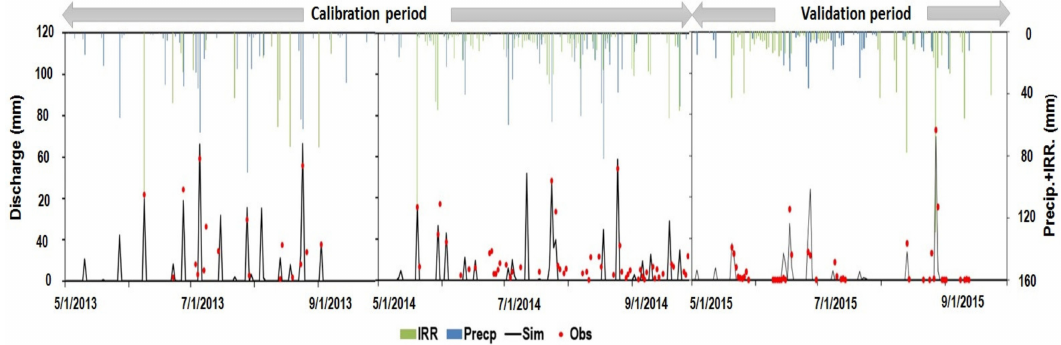
Figure 3. Predicted paddy field discharges are calibrated for the growing season in 2013–2014 and then validated for the year 2015 at the Iksan experiment